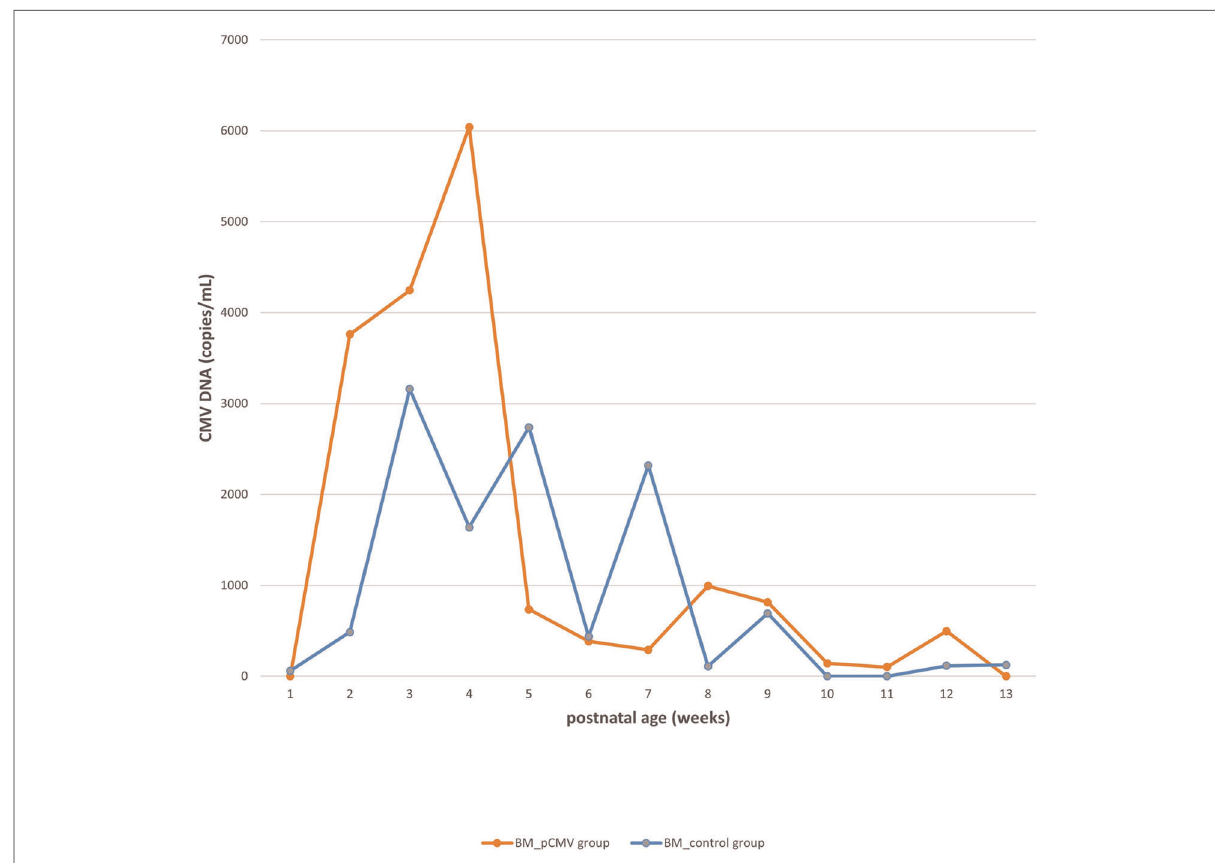
FIGURE 2 The kinetics of cytomegalovirus loads in breast milk. Orange and blue lines indicate the median copy numbers of CMV DNA in the breast milk of pCMV and control groups. CMV, cytomegalovirus; BM, breast milk; pCMV, postnatal